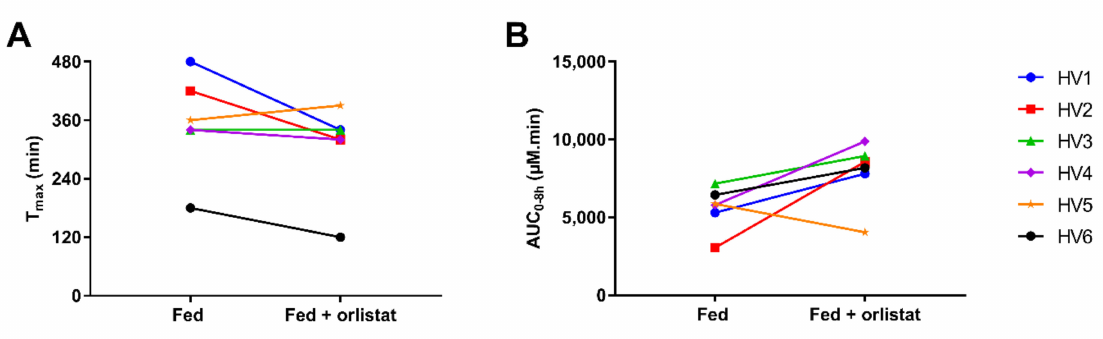
Figure 4. Comparison of the individual systemic pharmacokinetic parameters ( A ) T max and ( B ) AUC 0–8h after intake of Fenogal (200 mg fenofibrate) in the fed state (left) and fed state with orlistat